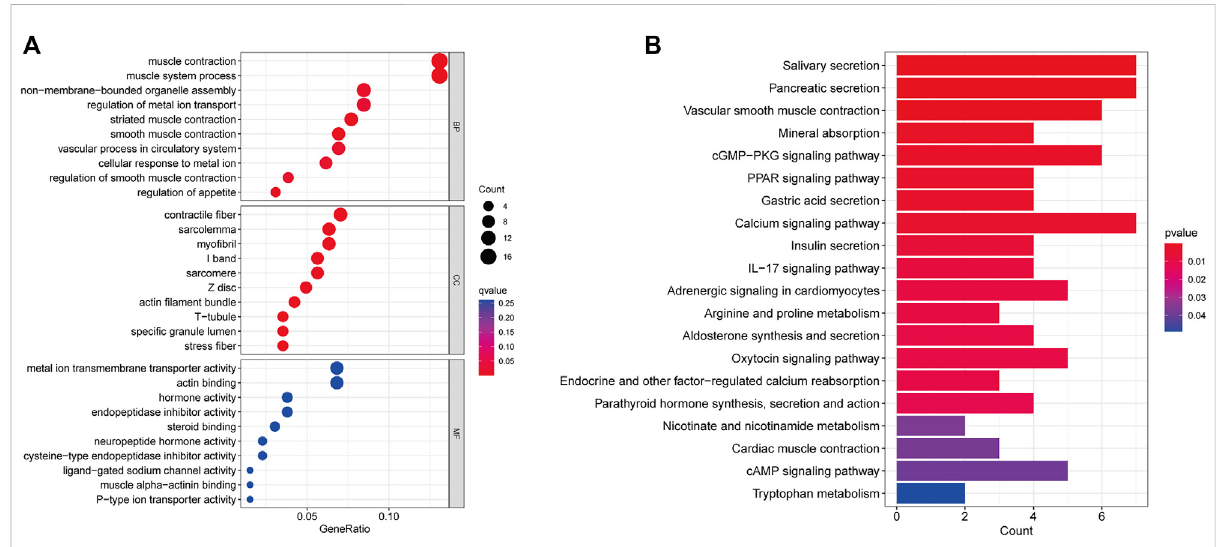
FIGURE 5 CRL functional enrichment analysis. (A) Bubble diagram showing results of GO enrichment analysis of prognostic CRLs. (B) Bar plot showing results of KEGG enrichment analysis of prognostic CRLs. BP: biological process, CC: cellular component, MF: molecular